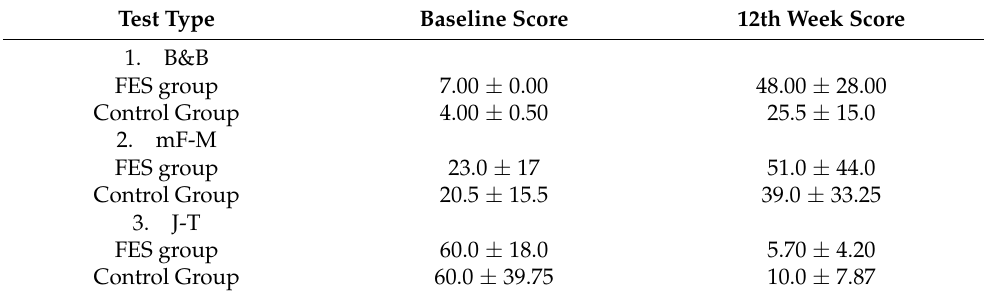
Table 6. Improvement Analysis of UL